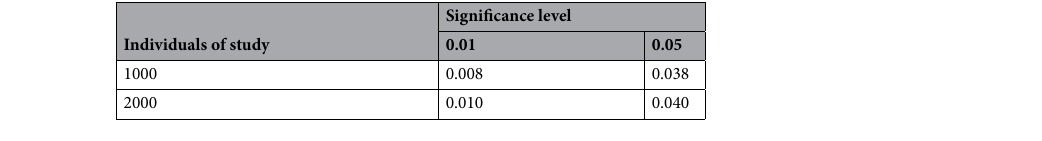
Table 3. The values of type I error rates at different scenarios for the test of SNP and SNP-environment joint effects with 10% overlapping data.